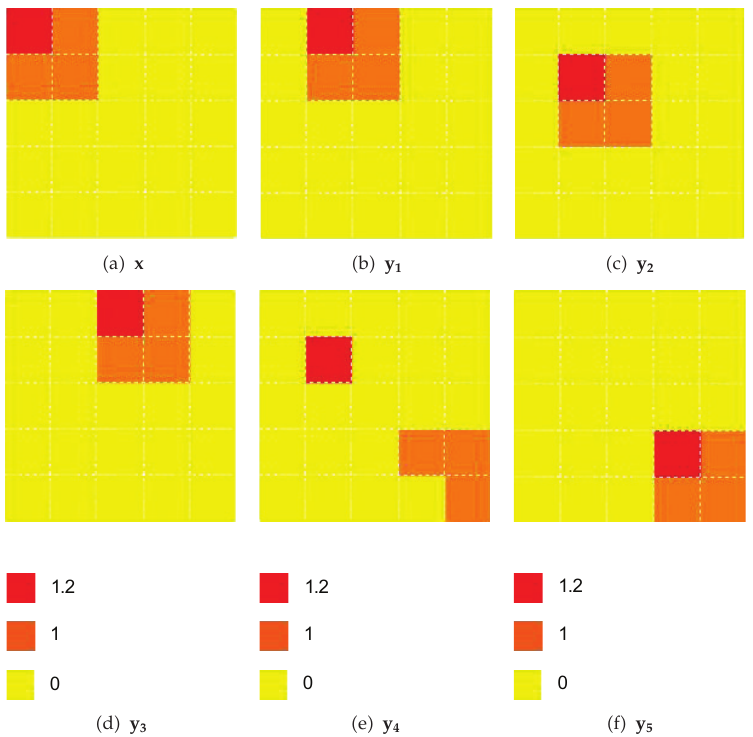
Figure 3: Example of a simulated two-dimensional source space: actual source distribution (cid:2) a (cid:3) and recon- structed sources (cid:2) b (cid:3) – (cid:2) f (cid:3)